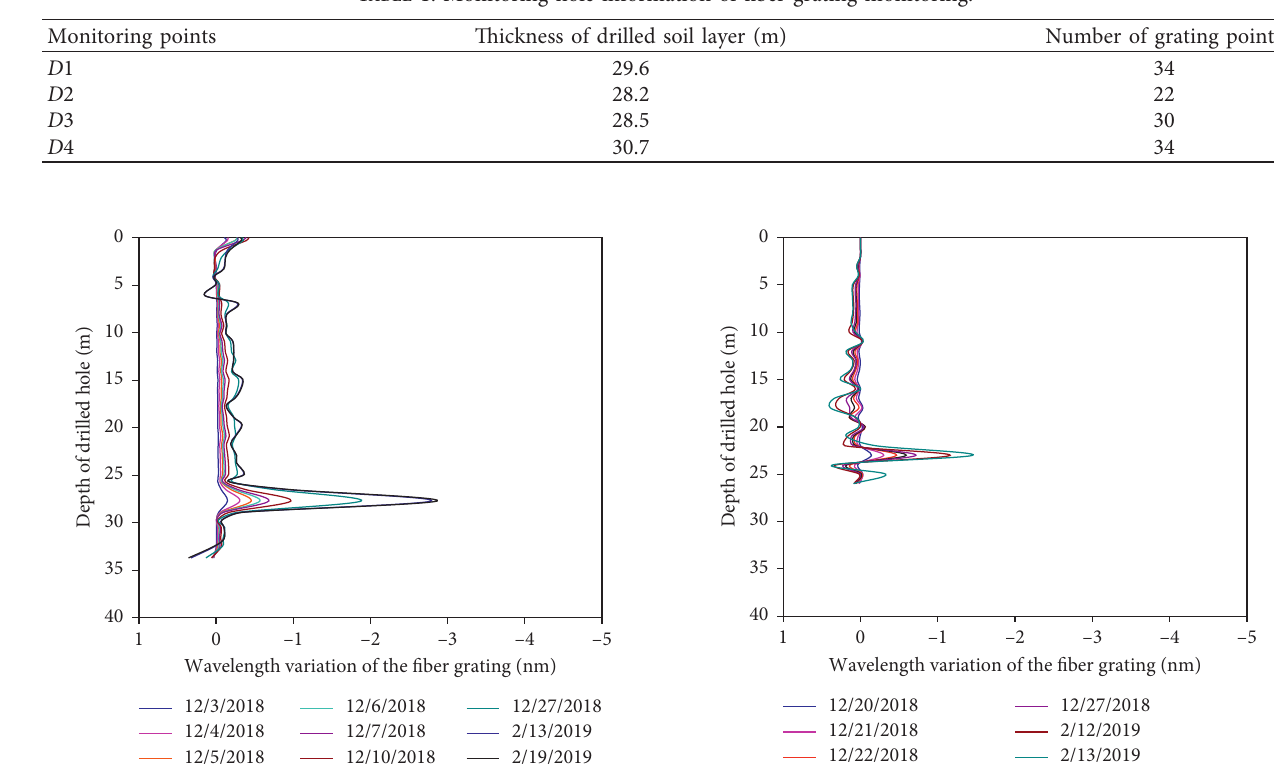
Figure 10: Wavelength of fiber grating at D 1.